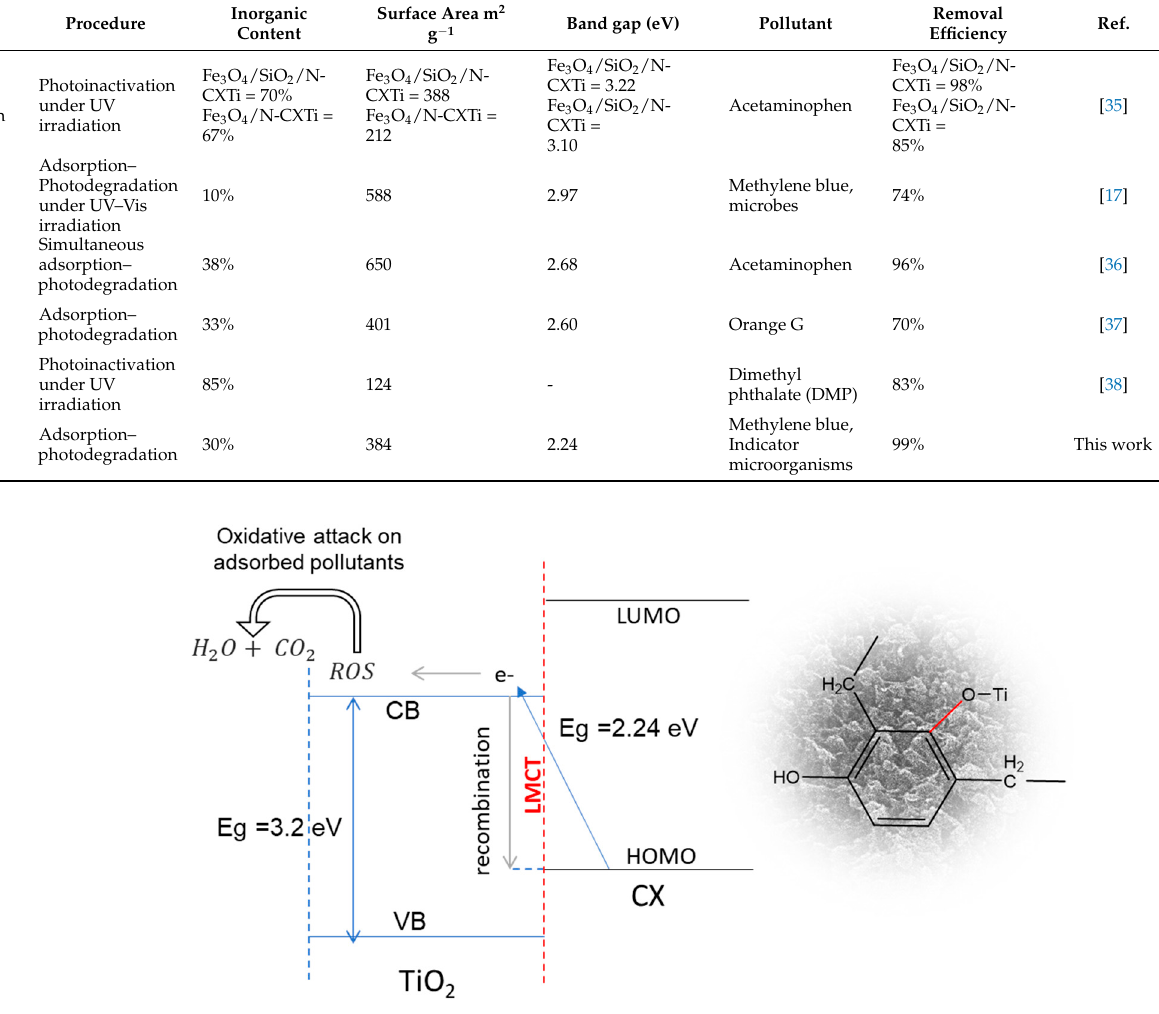
Table 3. Characteristics and degradation performance of comparable systems.